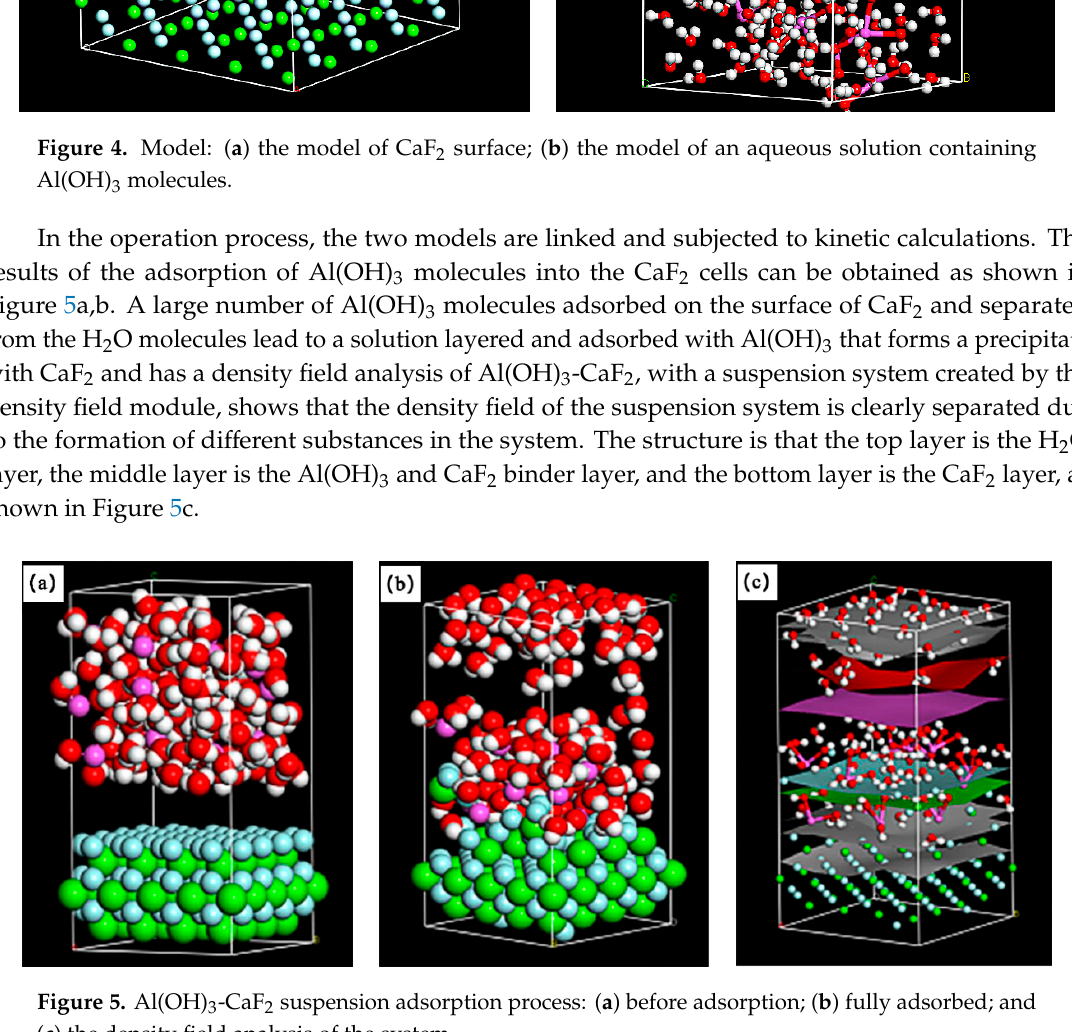
Figure 5. Al(OH) 3 -CaF 2 suspension adsorption process: ( a ) before adsorption; ( b ) fully adsorbed; and ( c ) the density field analysis of the ( c ) the density field analysis of the system.